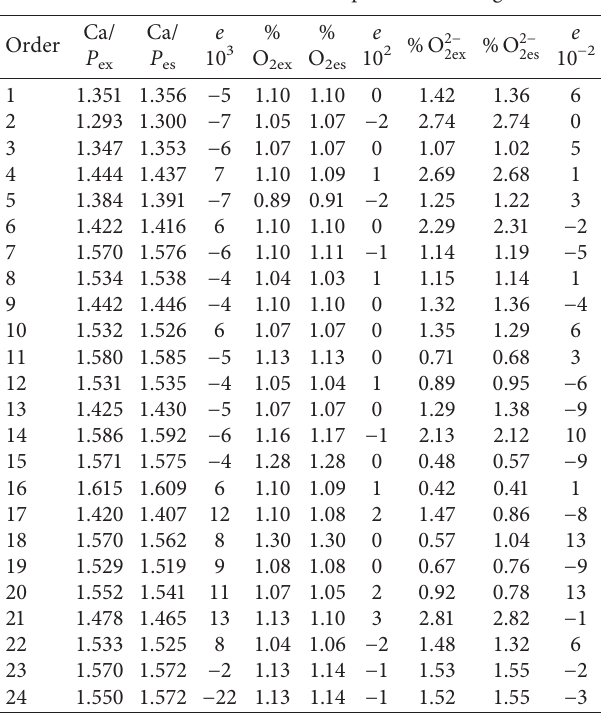
Table 7: Validation of the experimental design.